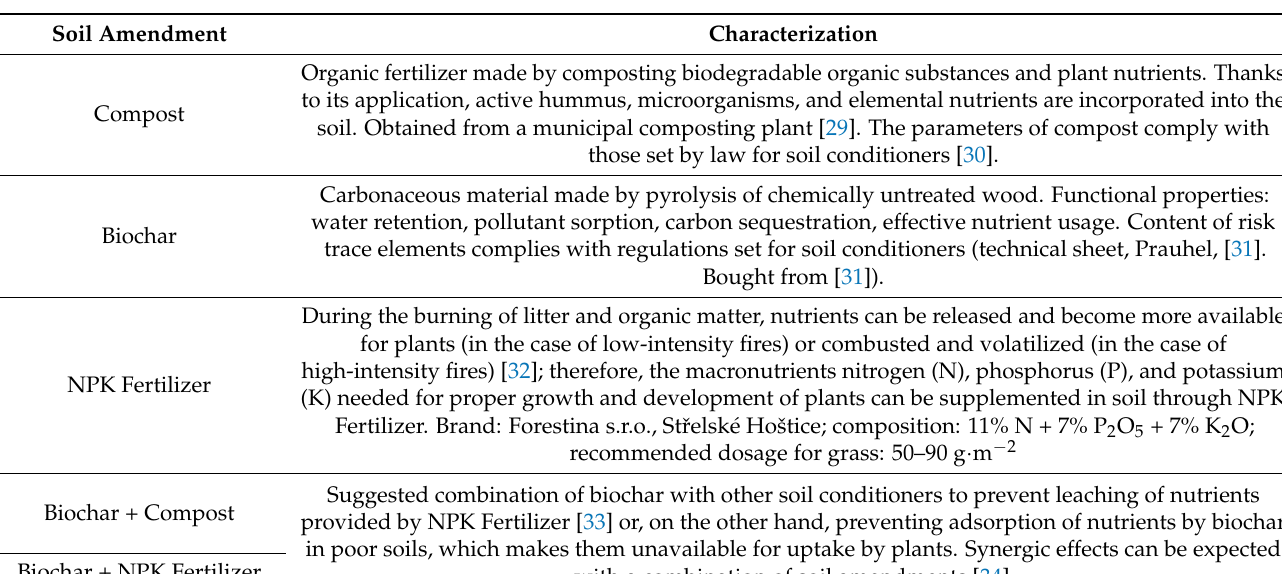
Figure 2. GPS localization of collection points. Table 1. Characterization of soil